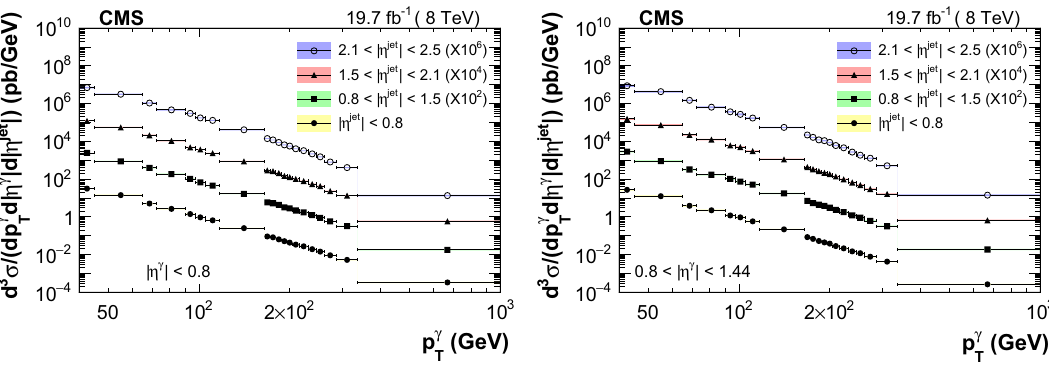
10 6 for 0 . 8 < | η jet | < 1 . 5, 1 . 5 < | η jet | < 2 . 1, and 2 . 1 < | η jet | < 2 . 5 respectively.Thestatistical(systematic)uncertaintiesareshownaserror bars (color bands)